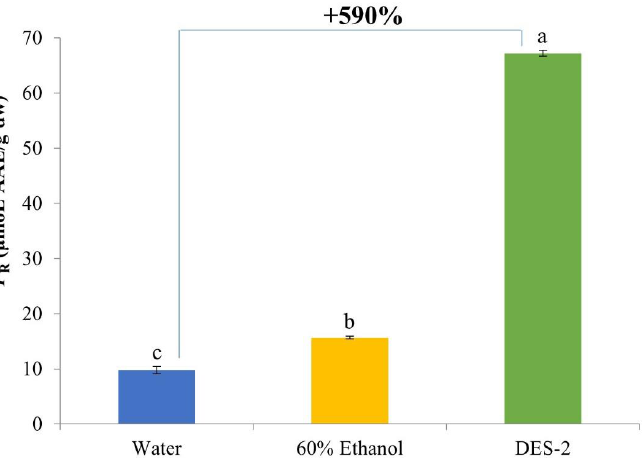
Figure 3. FRAP antioxidant activity ( P R , µ moL AAE/g dw) of extracts from APW using various solvents and DES-2 obtained by the optimum extraction conditions; Standard deviation is presented with error bars and means with different superscript letters are significantly ( p < 0.05) different.